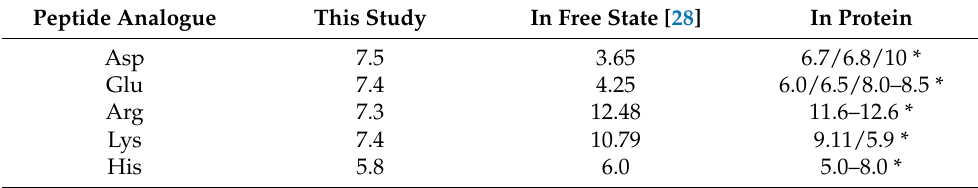
Table 6. pKa values for sidechain of peptide analogues (absence of α -amino group effect) [26]. Peptide Analogue This Study In Free State [28] In Protein